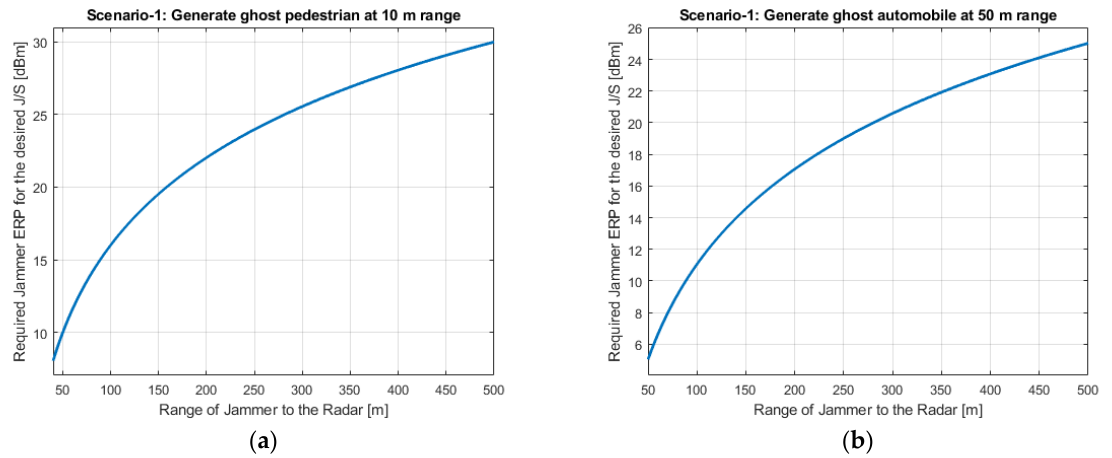
Figure 5. Jammer ERP versus range of the jammer for Scenario-1. ( a ) For the pedestrian false echo scenario; ( b ) For the automobile ghost echo scenario.